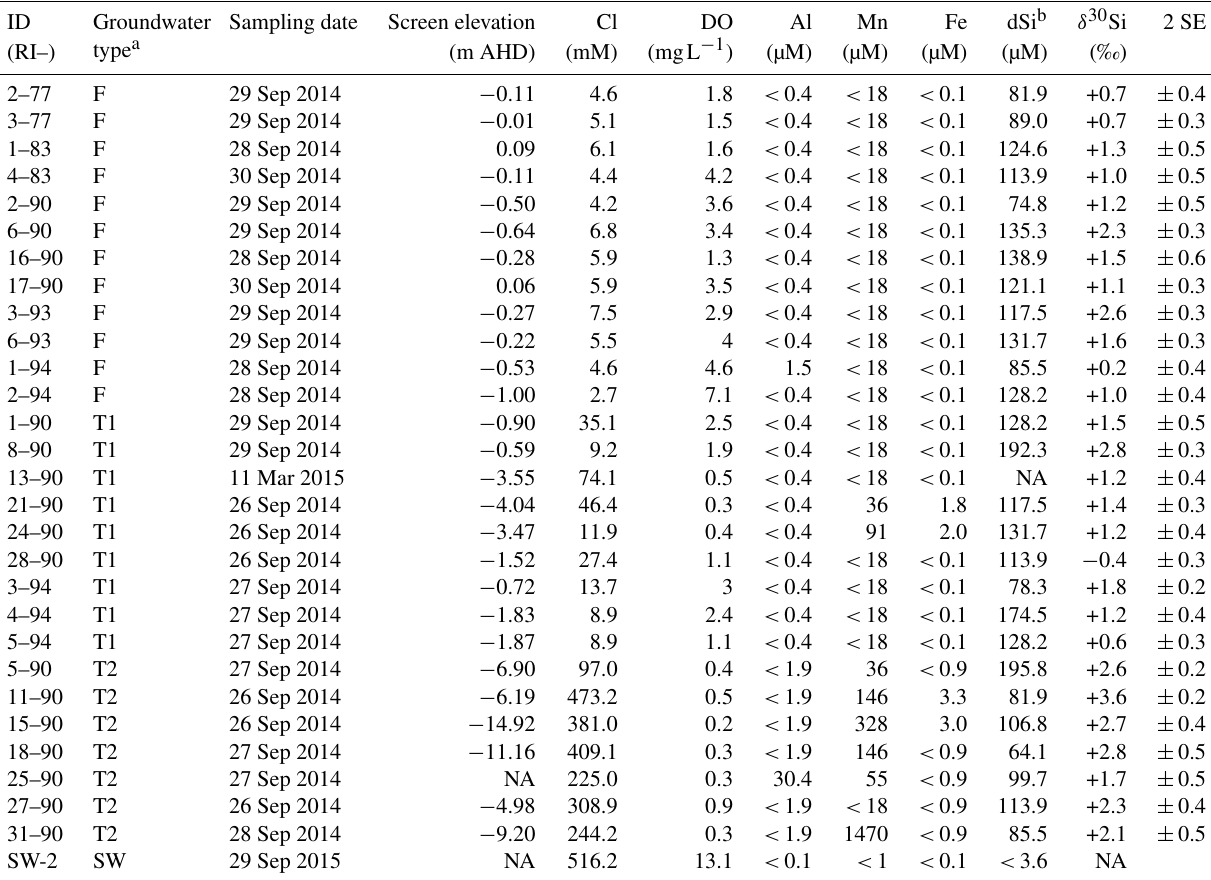
Table 1. The dSi concentrations and isotopic ratios and for groundwater and a seawater sample from Rottnest